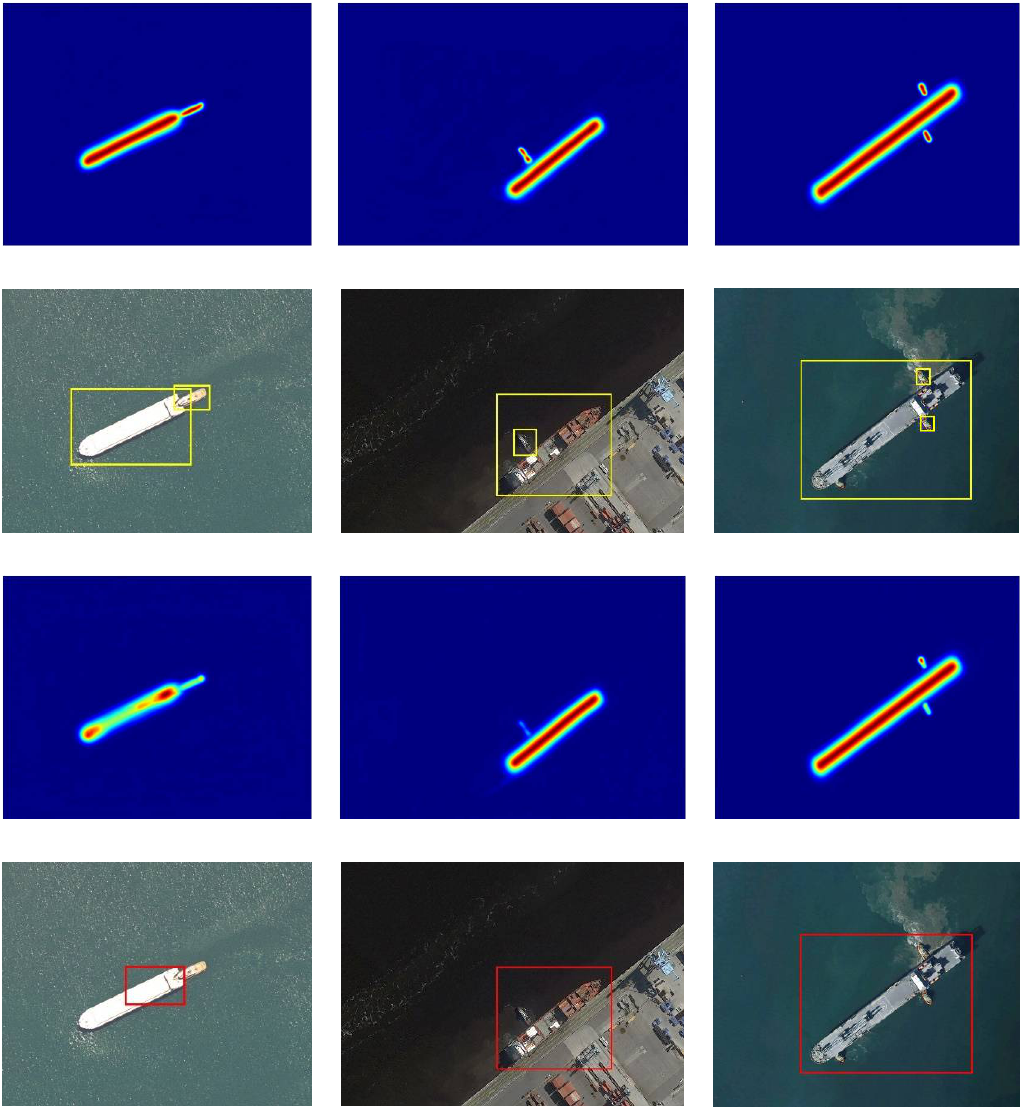
Figure 14. Examples of worse results after using TTA. From top to bottom, the first and second rows represent the ship feature maps and polygon annotations obtained without using TTA, and the third and fourth rows represent the ship feature maps and polygon annotations obtained after using TTA.